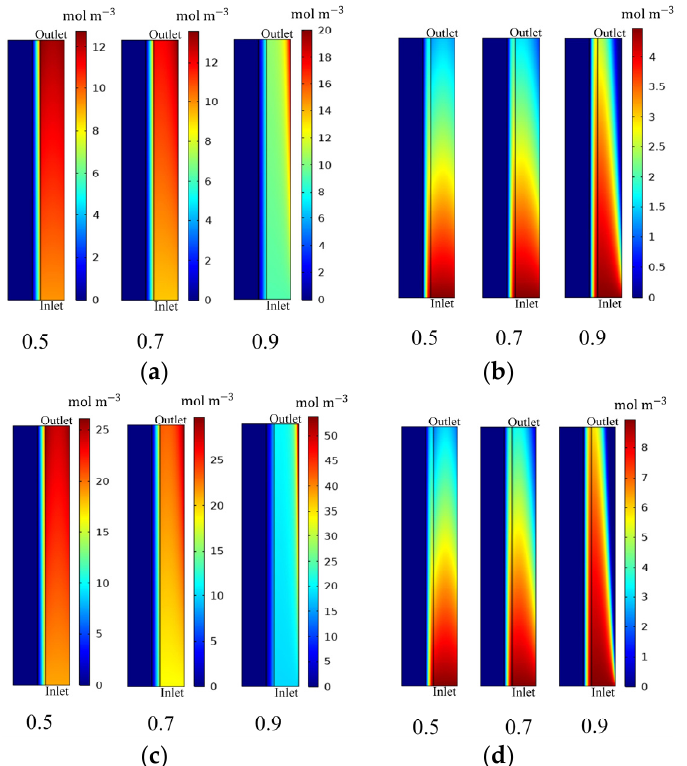
Figure 12. Bromine concentration distribution in the positive electrode at ( a ) t = 0.2 h and ( b ) t = 0.9 h for battery with different electrode porosities at a current density of 20 mA cm − 2 and at ( c ) t = 0.2 h and ( d ) t = 0.9 h for battery with different electrode porosities at a current density of 40 mA cm − 2